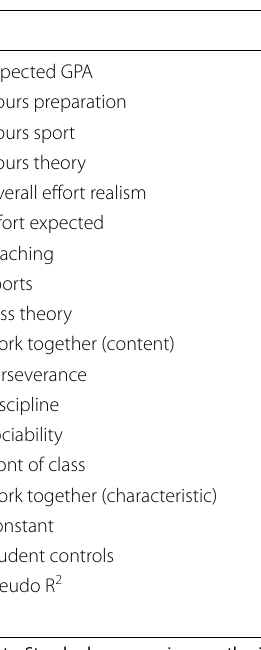
Table 4 Estimation results future